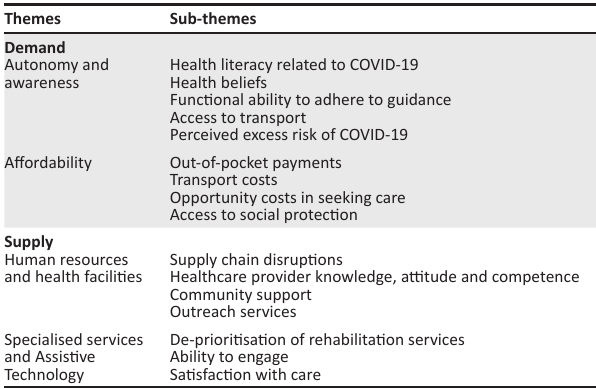
TABLE 2: Overview of